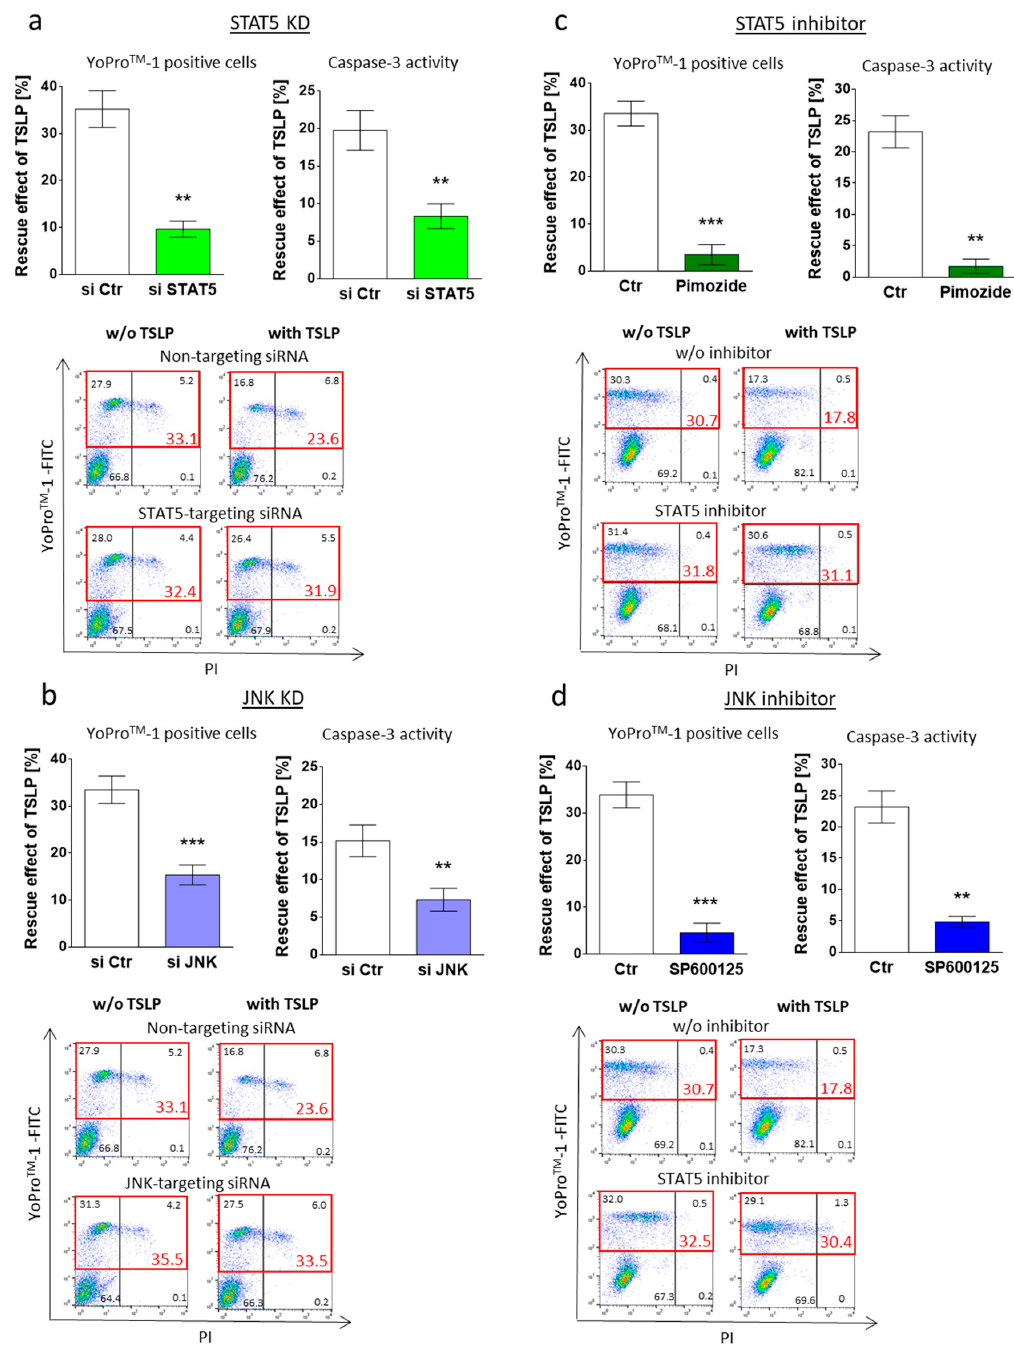
Figure 3. MC maintenance by TSLP critically depends on JNK and STAT5 activation. Impact of ( a , c ) STAT5 and ( b , d ) JNK perturbation on TSLP-promoted MC recovery (at 7.5 ng / mL) after 8 h, evaluated by the ratio of YoPro TM -1 positivity (corresponding to the percentage of early and late apoptotic / necrotic cells combined) in TSLP-treated versus untreated MCs (described in methods). ( a , b ) Interference by Accell ® -mediated RNAi (48 h prior to TSLP treatment); ( c , d ) interference by specific inhibitors (STAT5 inhibitor: pimozide, JNK inhibitor: SP600125). Top: the results represent the mean ± SEM of six independent experiments. Bottom: representative flow cytometry dot plots (specified in red is the percentage of early and late apoptotic / necrotic cells combined); w / o—without. The data were analyzed by paired t -test, ** p < 0.01, *** p < 0.001.